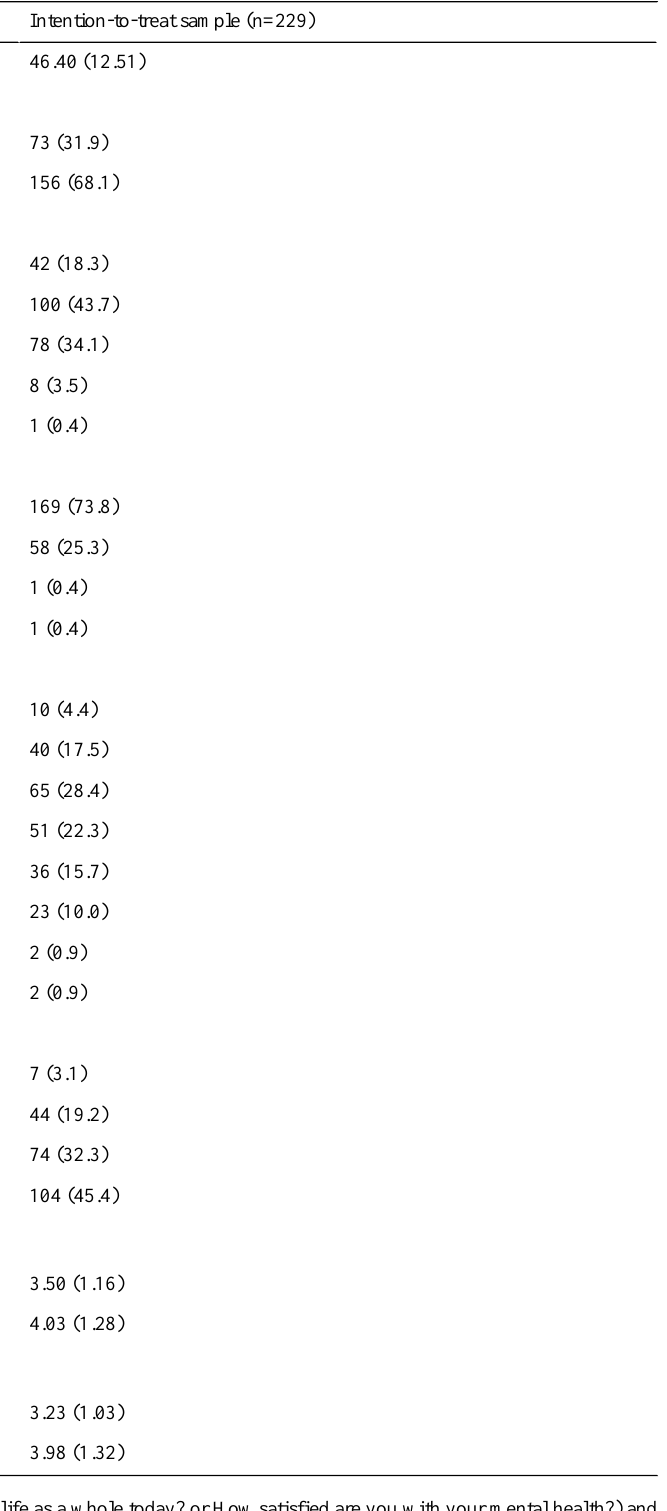
Intention-to-treat sample